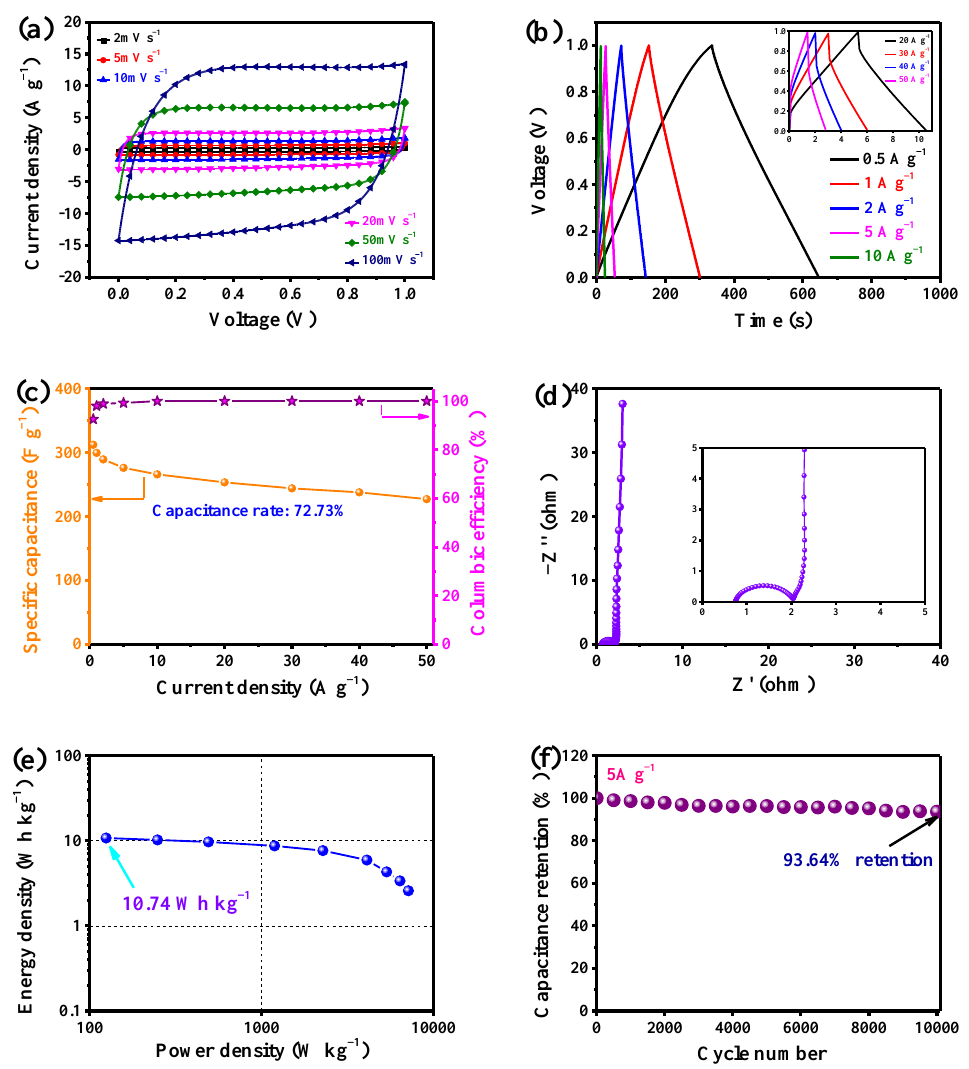
Figure 10. Electrochemical performances of the assembled all-solid-state SC device using LSPC800 as electrode in PVA/KOH gel electrolyte: ( a ) CV curves at scan rates varying from 5 to 100 mV s −1 ; ( b ) GCD curves at different current densities; ( c ) specific capacitance and coulombic efficiency at different current densities; ( d ) the Nyquist plot; ( e ) the Ragone plot; and ( f ) the long-cycles performance at 5 A g −1 .